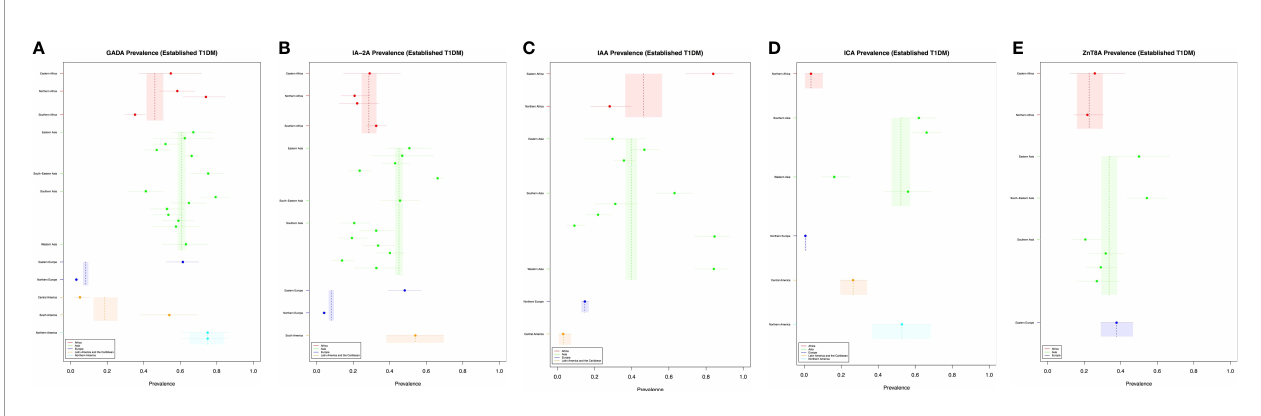
FIGURE 3 | (A – E) Established T1DM and islet autoantibody